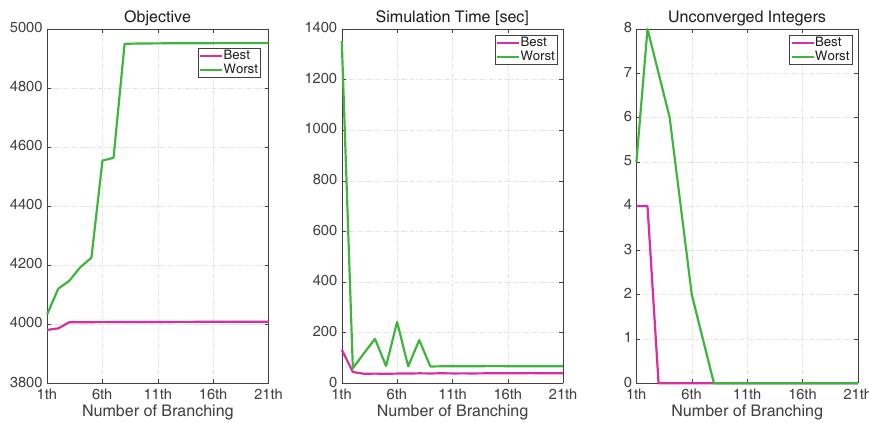
Figure 6. Comparison of the best and worst branch-and-bound (BB) search tree results.